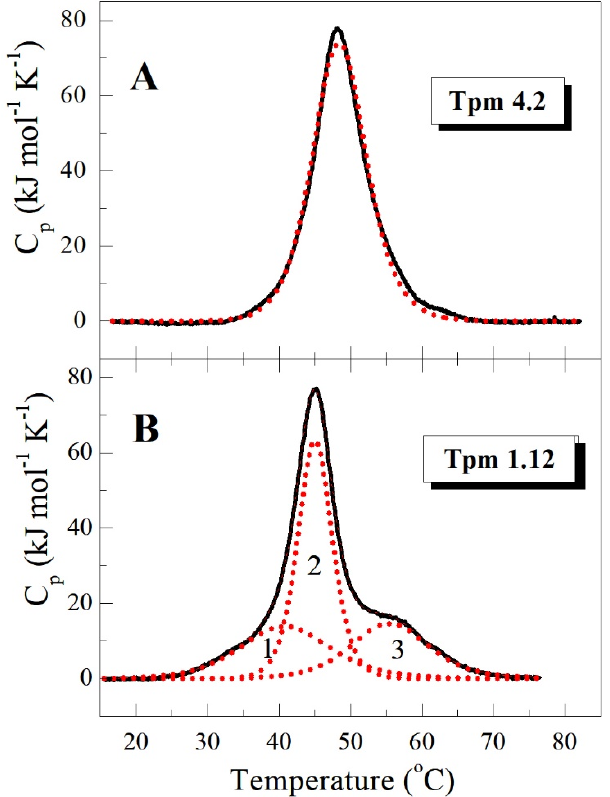
Figure 3. Temperature dependences of the excess heat capacity (Cp) monitored by DSC and the results of the deconvolution analysis of the heat sorption curves for LMW Tpm isoforms Tpm4.2 ( A ) and Tpm1.12 ( B ). Solid black lines represent the experimental curves after subtraction of instrumental and chemical baselines, and dotted red lines represent the individual thermal transitions (calorimetric domains) obtained from fitting the data to the non-two-state model.